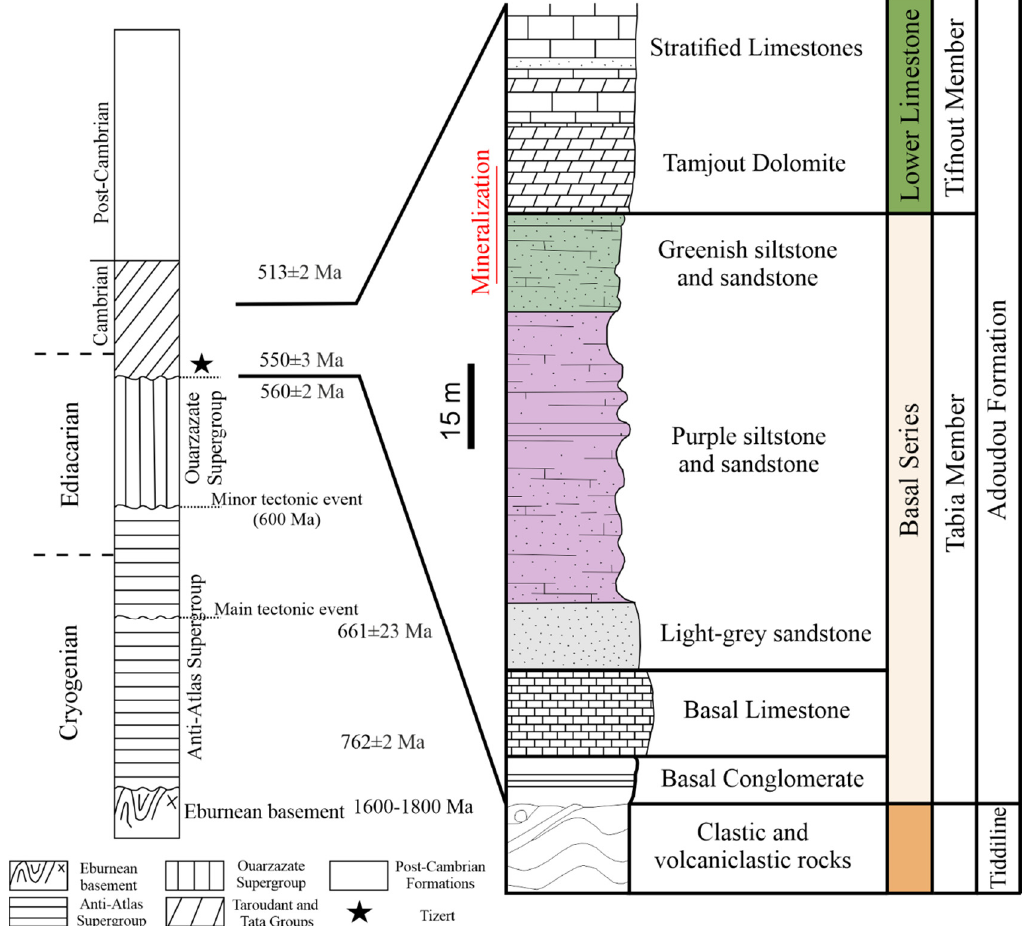
Figure 2. Simplified lithostratigraphy of the Anti-Atlas (left) and major geological units observed in the Tizert deposit (right) (Modified from references [4,13,33]).